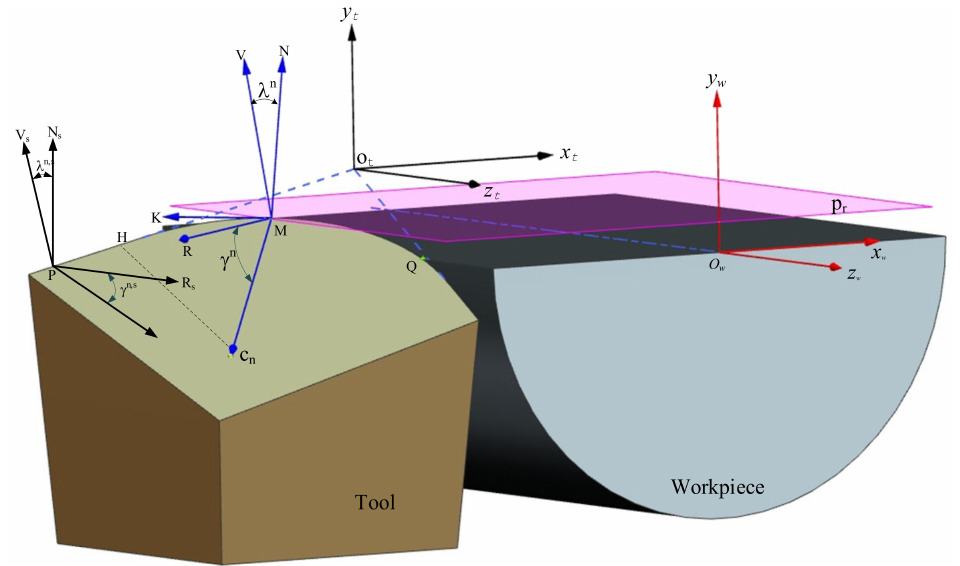
Figure 5. Illustration of the working normal rake angle (NRA) and inclination angle on